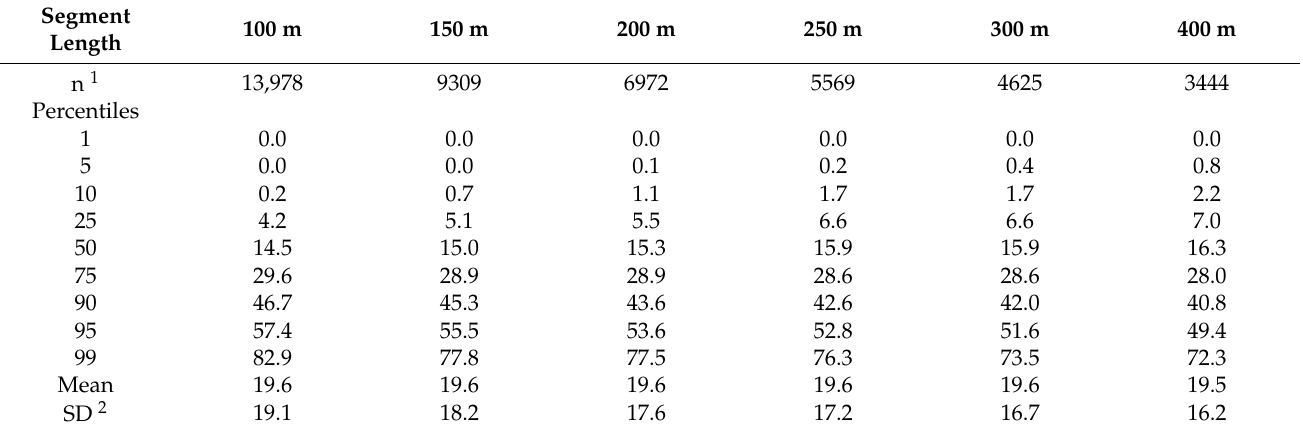
Table 3. Univariate statistics for the percentages of the canopy within the buffered